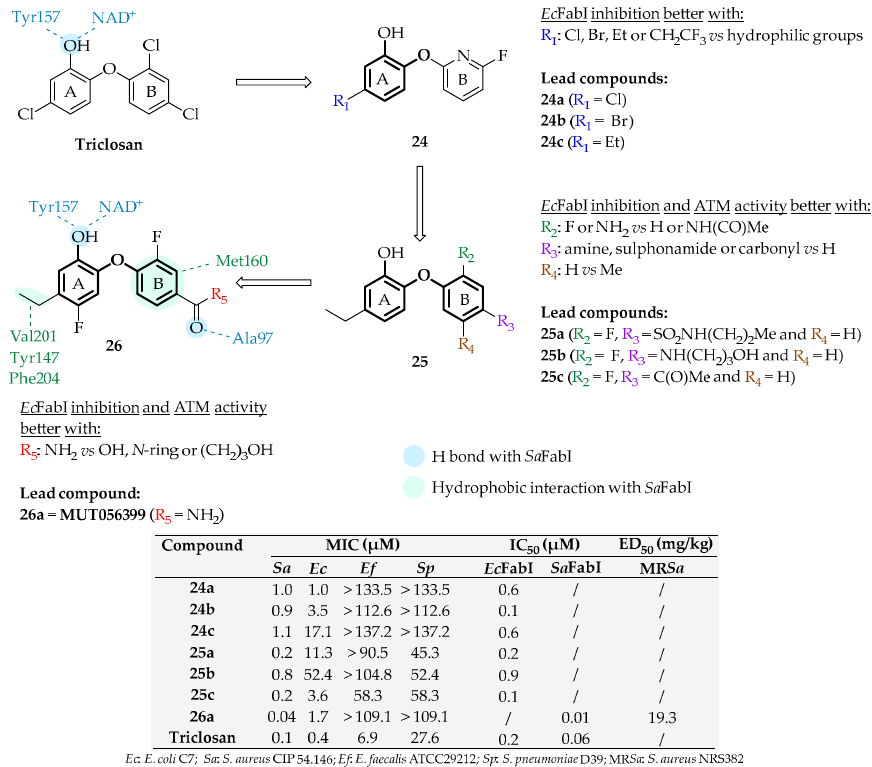
Figure 27. Structure, SAR and representation of the main interactions with Sa FabI of triclosan derivatives 24–26 and in vitro activities of lead compounds [146].